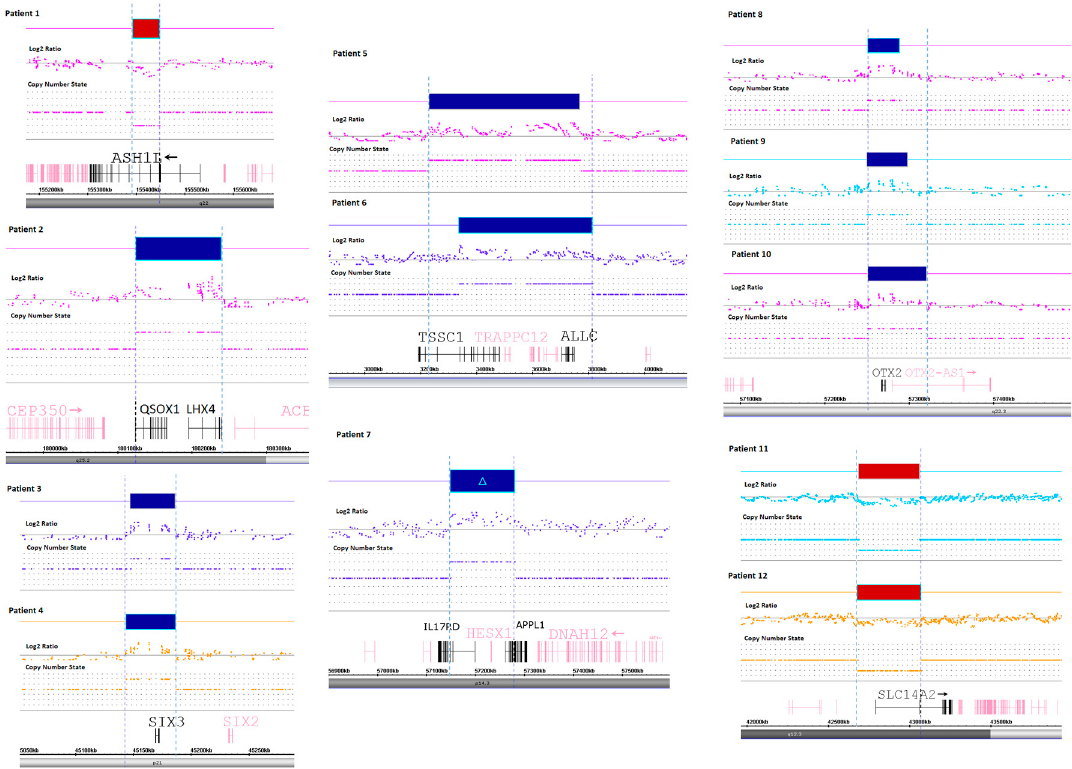
Figure 1. Microarray rearrangements detected in CPHD patients. Detected regions in patients are shown in top section (in red—deletions, in blue—duplications), followed by Log2 Ratio plot, copy number state, gene map and cytoband (bottom section). Patient numbers correspond to those presented in Tables 1 and 2.